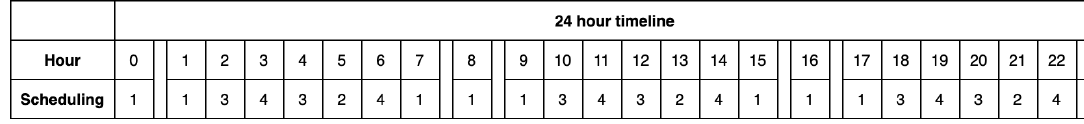
Figure 7. Example of timeline for the scheduling